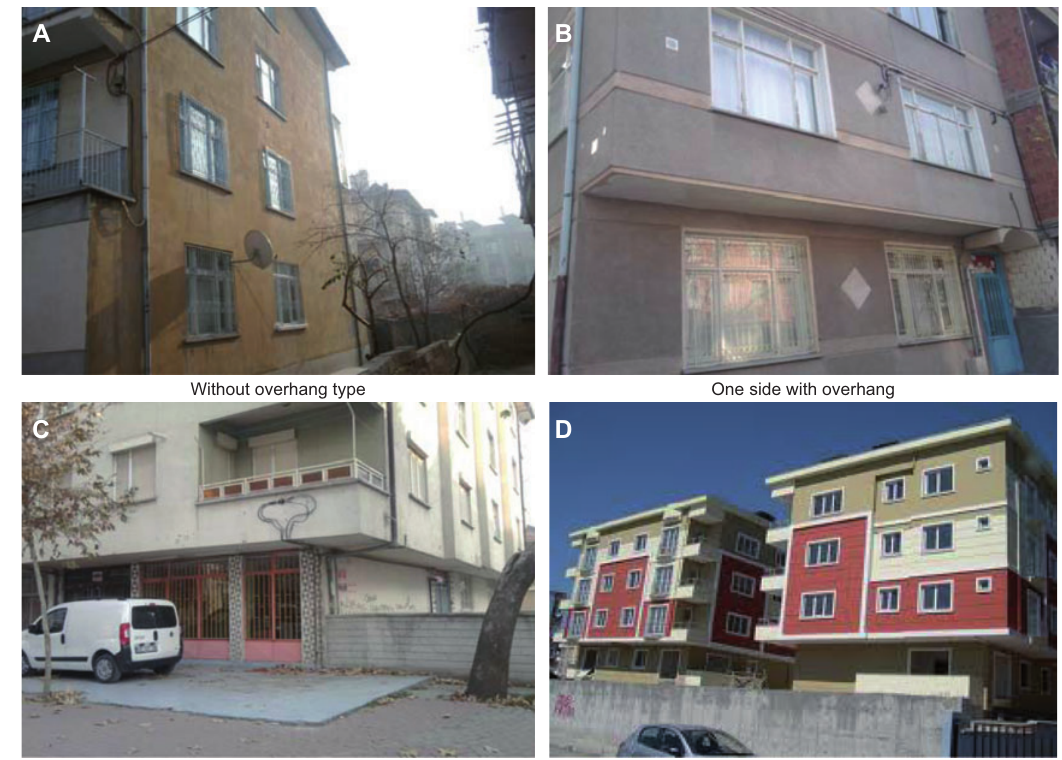
Figure 2 Types of